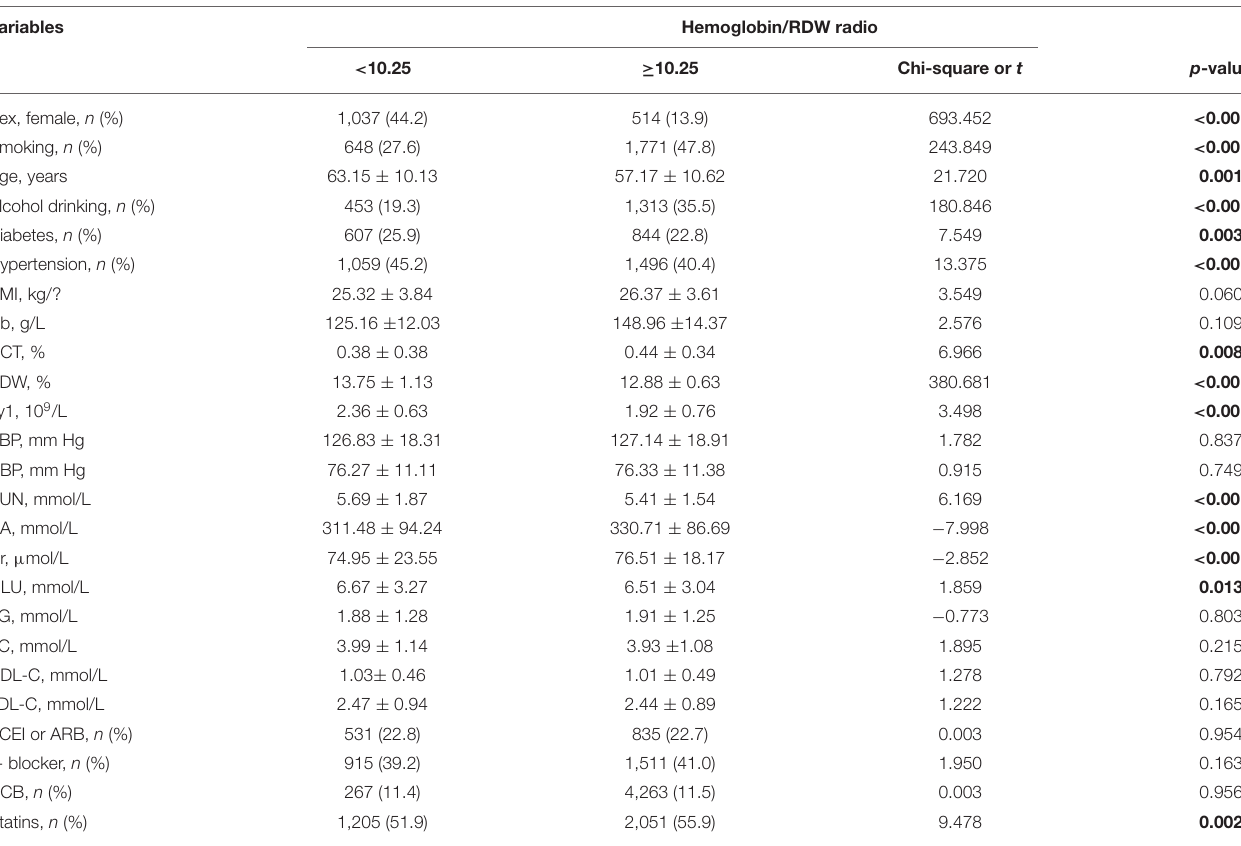
TABLE 1 | Characteristics of participants of the two